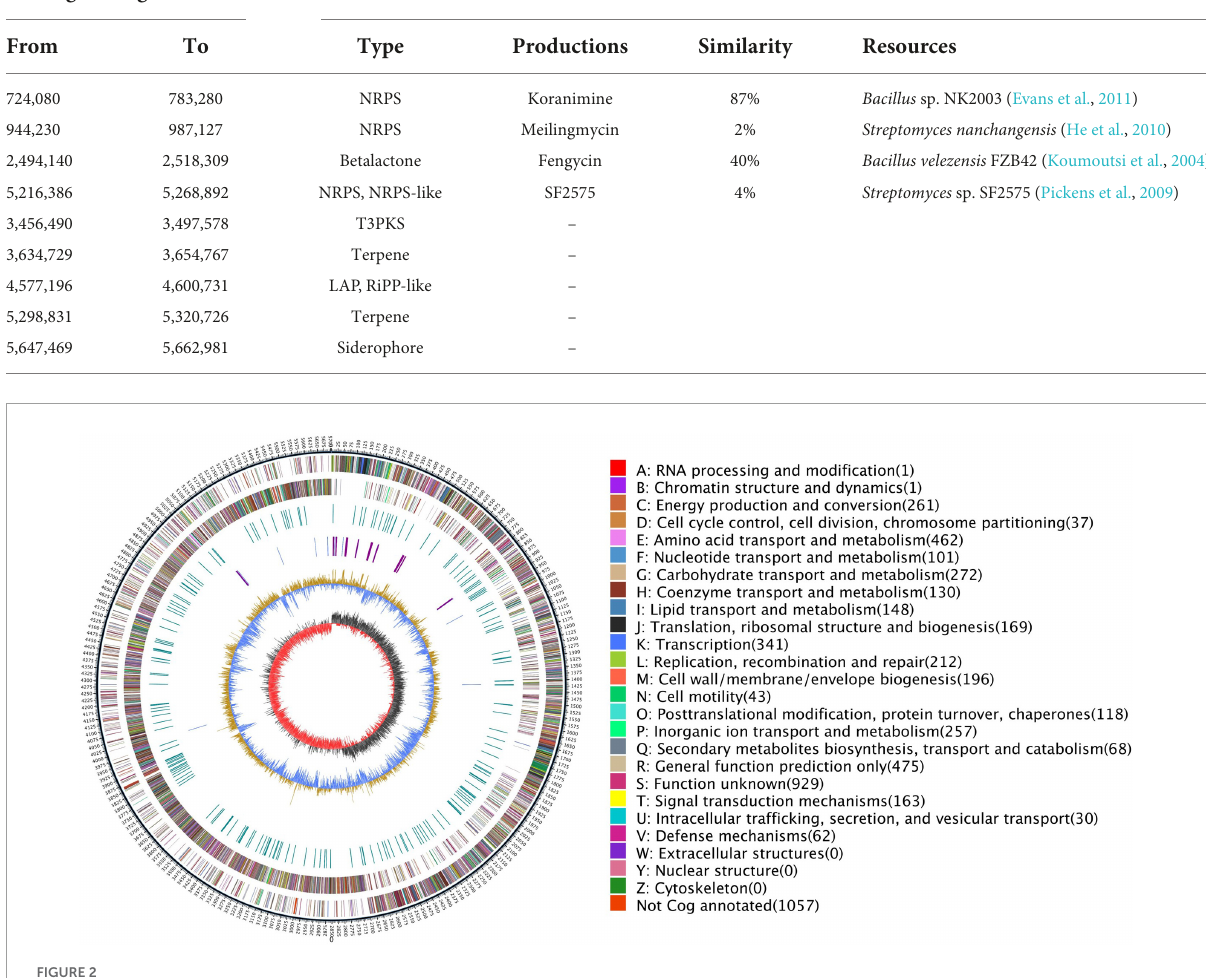
TABLE 2 Predictive gene clusters involved in synthesis of secondary metabolites in Q2H1. Region of genome